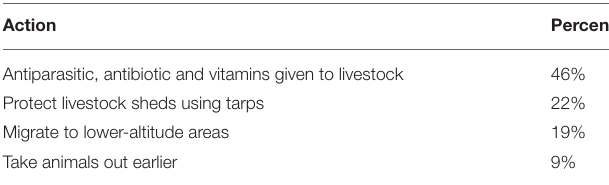
Action Percent Antiparasitic, antibiotic and vitamins given to livestock Protect livestock sheds using